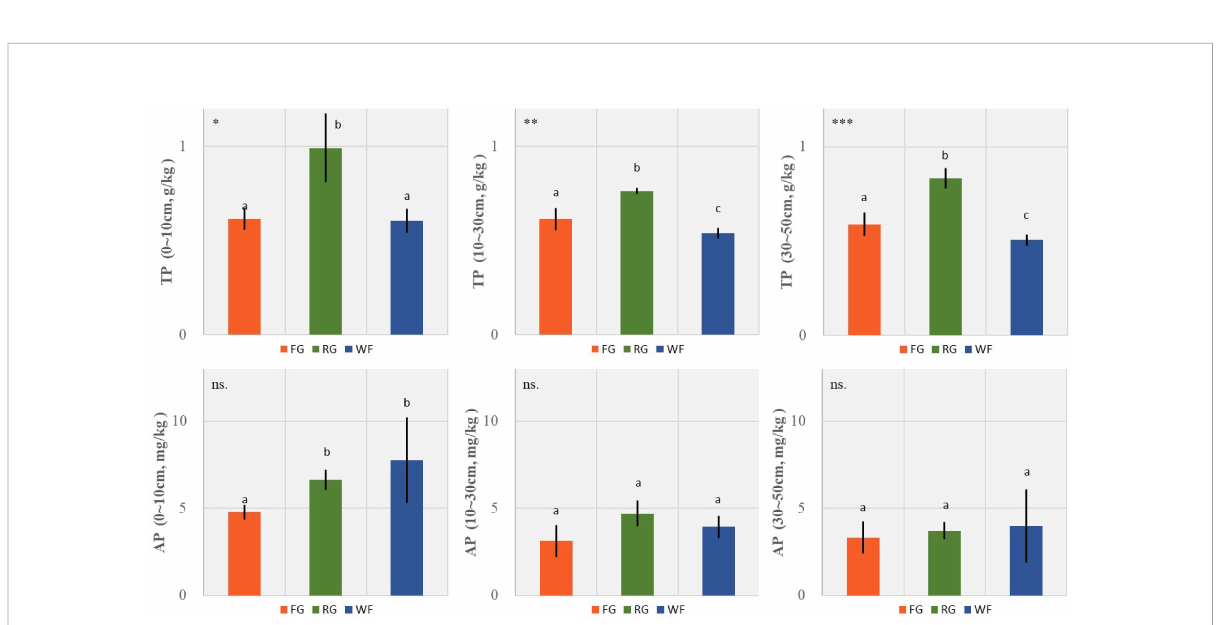
FIGURE 6 Effects of different grassland managements on soil total phosphorus (TP, mean ± SD) and available phosphorus (AP, mean ± SD) at Maqin alpine meadow. FG: free grazing, RG: arti fi cial grass planting, WF: enclosure; “ *** ” , “ ** ” , “ * ” and “ ns. ” represent signi fi cant relationship of P < 0.001, P < 0.01, P < 0.05 and P > 0.05, respectively. Different letters above histogram indicate signi fi cant differences ( P < 0.05) between two grassland